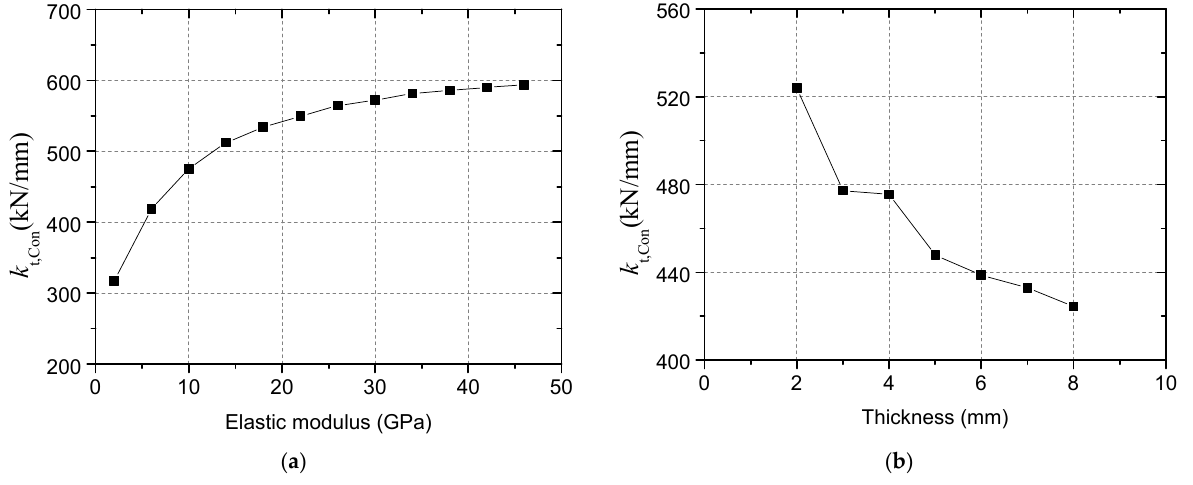
Figure 21. Effect of properties of the weak region on the stiffness: ( a ) Elastic modulus; ( b ) Thick- ness.